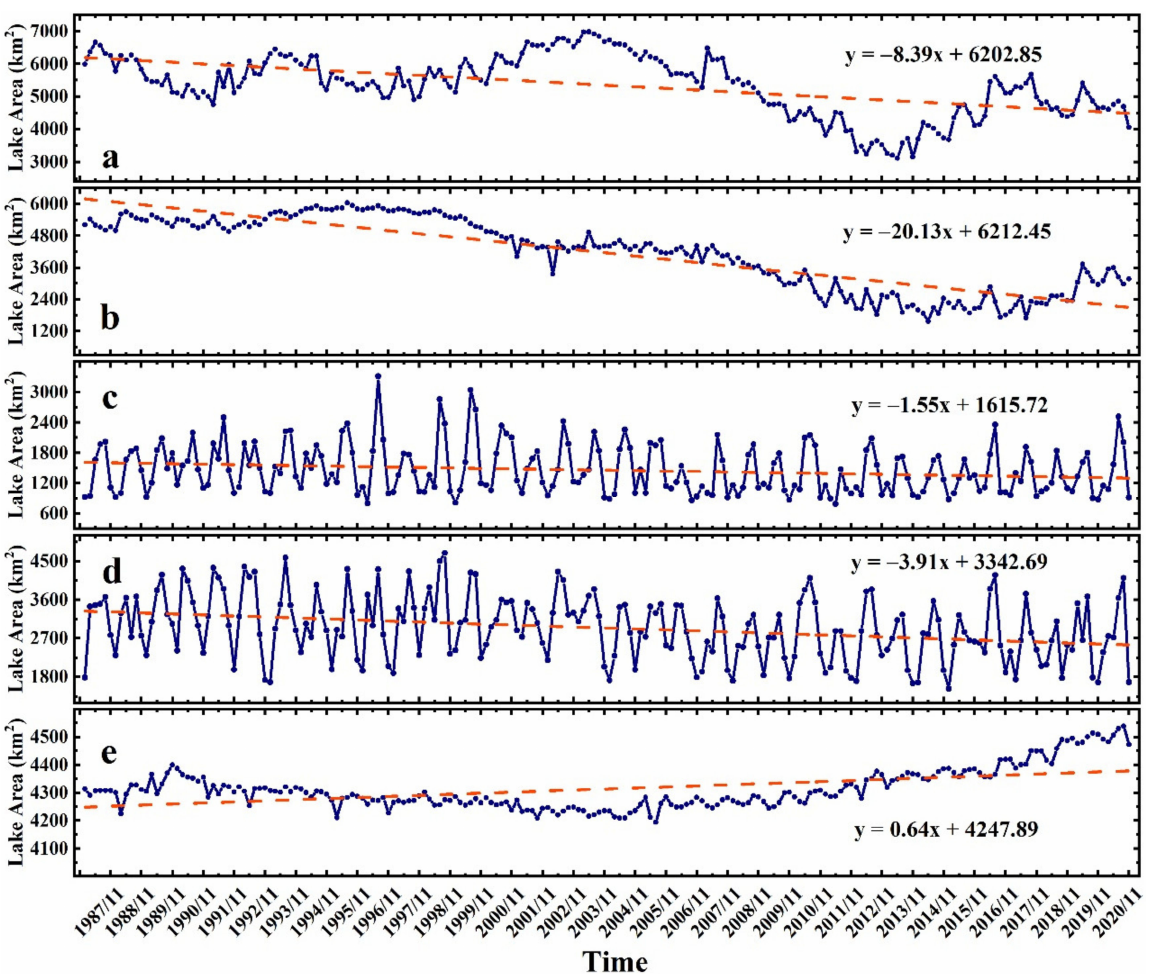
Figure 7. Illustration of the bimonthly sequences and change trend of lake area for five case lakes. ( a ) Chiquita Lake; ( b ) Urmia Lake; ( c ) Dongting Lake; ( d ) Poyang Lake; and ( e ) Qinghai